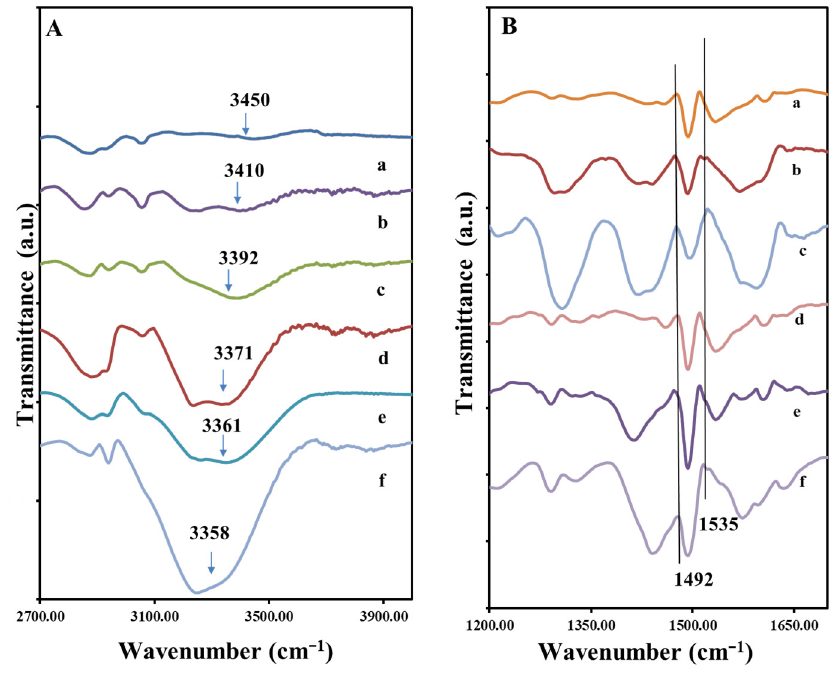
Figure 2. FTIR spectra of different composition of hydrogels ( A ) from top to bottom in the order of increasing Gly concentration in the composites (a) AM2, (b) AM10, (c) AM9, (d) AM7, (e) AM11, (e) AM8; ( B ) spectra of composite organized from top to bottom in the order of increasing PANi (a) AM2, (b) AM7, (c) AM8, (d) AM9, (e) AM10, (f) AM11.